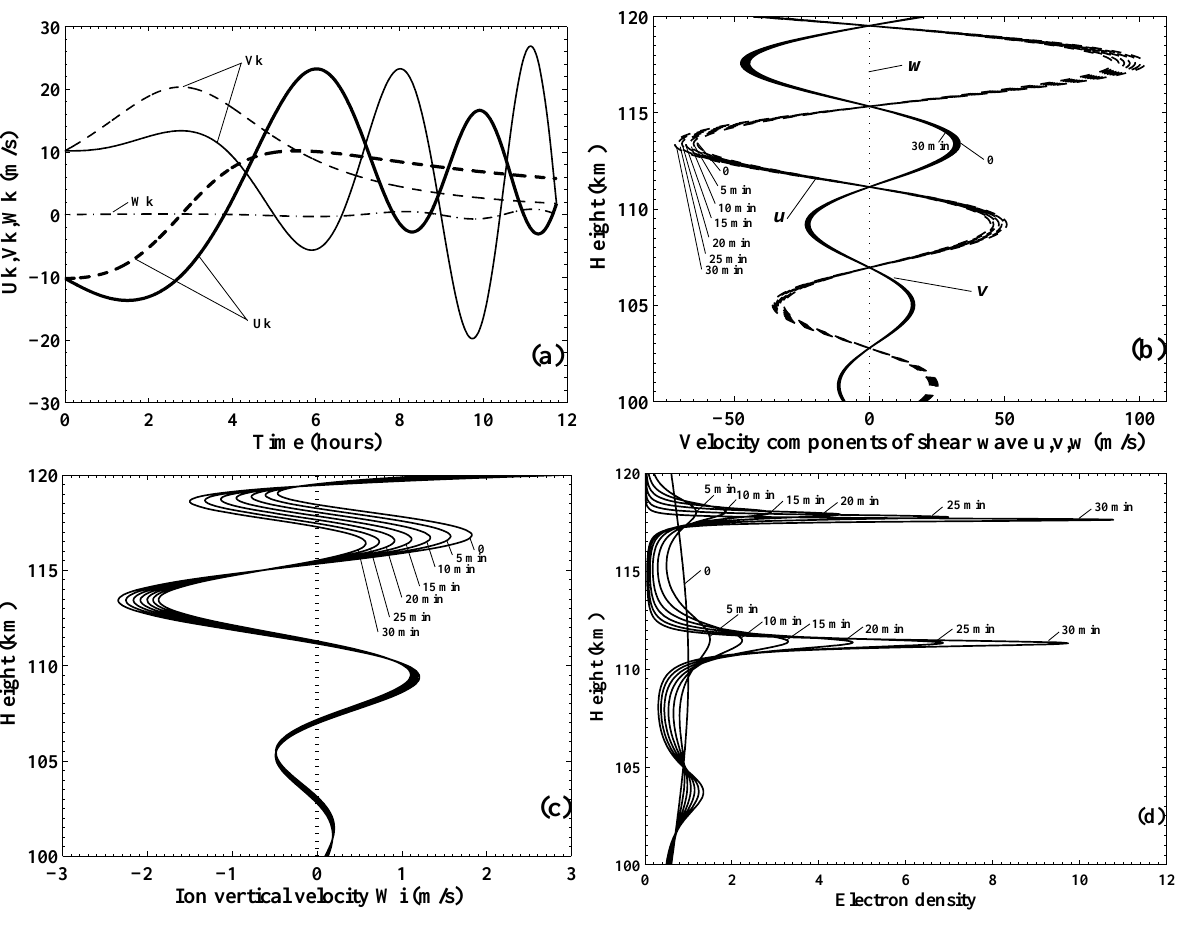
Fig. 2. (a) Temporal development (at h = h 0 = 94km) of the shear wave velocity spatial amplitudes U k (t) (dark dashed line – analytical approach, dark solid line – numerical simulation), V k (t) (dashed line – analytical approach, solid line – numerical simulation) and W k (t) (dash-dotted line), (b) height variations of horizontal u(h,t) (dashed line), v (h,t) (solid line) and vertical w(h,t) (dotted line) components, (c) height variations of the ion vertical drift velocity w i (h,t) and (d) the formation of a sporadic E layer (for electron density) for time intervals: t = 0, 5, 10, 15, 20, 25 and 30min in the horizontal shear flow. The shear wave vertical wavelength λ z = 8km and the other parameters are the same as in Fig.